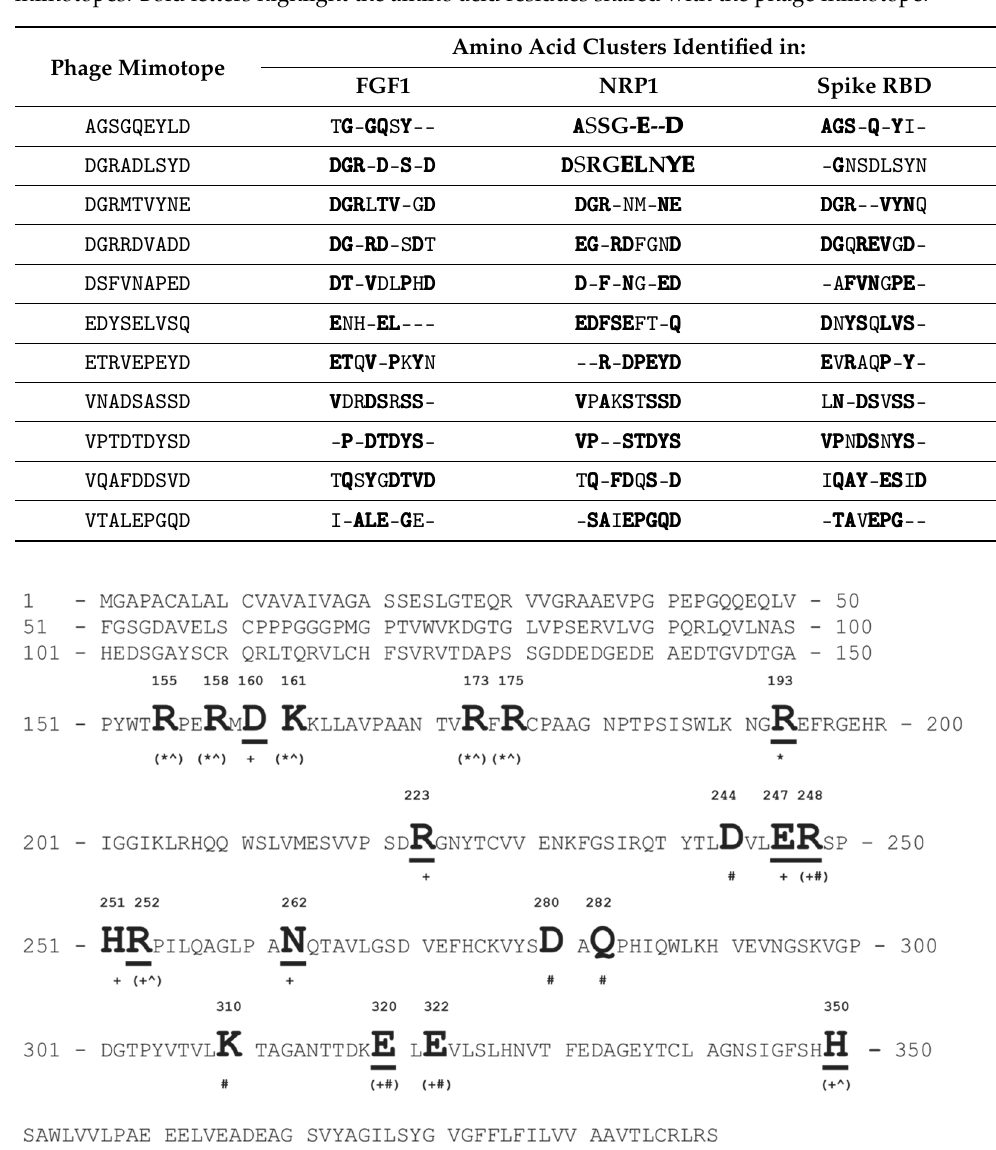
Figure 9. Primary structure of the FGFR3 domain. Amino acids involved in the interaction (desig- nated by capital bold letters) between FGF1 (*), NRP1 (^), and RBD (#) were identified using the YASARA Structure and literature data. Promiscuous amino acid residues of FGFR3 involved with the interaction of FGF1, NRP1, and spike RBD are marked with (*^#). Members of AA clusters cor- responding to the phage mimotope EDYSELVSQ are marked with (+) and indicated by underlined letters.